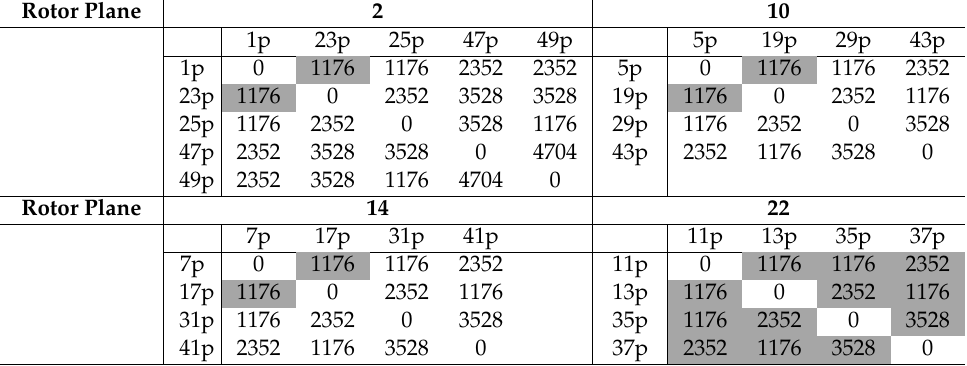
Table 4. Predicted torque pulsating components frequencies for the three-phase IM with 48 bars (in Hz). Rotor